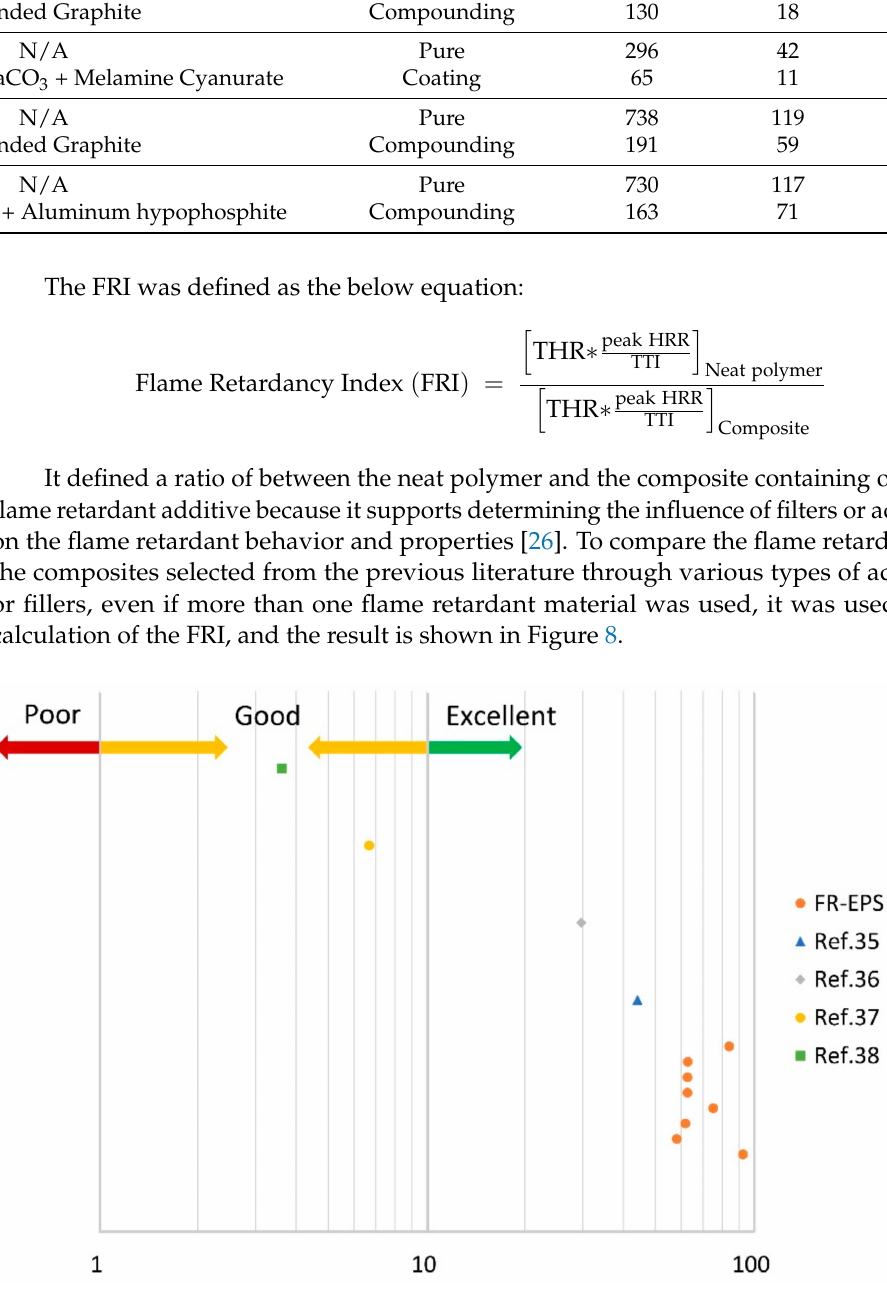
Figure 8. The calculated FRI for FR-EPS and the polystyrene composites containing the flame retardant. FRI < 1 symbolized “poor”, taken the lowest level of flame resistance. This meant that applying a flame retardant did not help improve the flame retardancy. If the applied flame retardant is effective, the calculated FRI value might be greater than 1. Thus, 1 < FRI < 10 symbolized “good”, and the FRI value in 10 < FRI < 100 indicated “excellent”. All of [35–38] satisfied FRI > 1, and 44.1 was calculated as FRI value for [35]. The FRI values of FR-EPS satisfied 58.2~92.7, and it can be seen that FR-EPS had a more efficient flame retardant strategy than the improved polystyrene composites from the